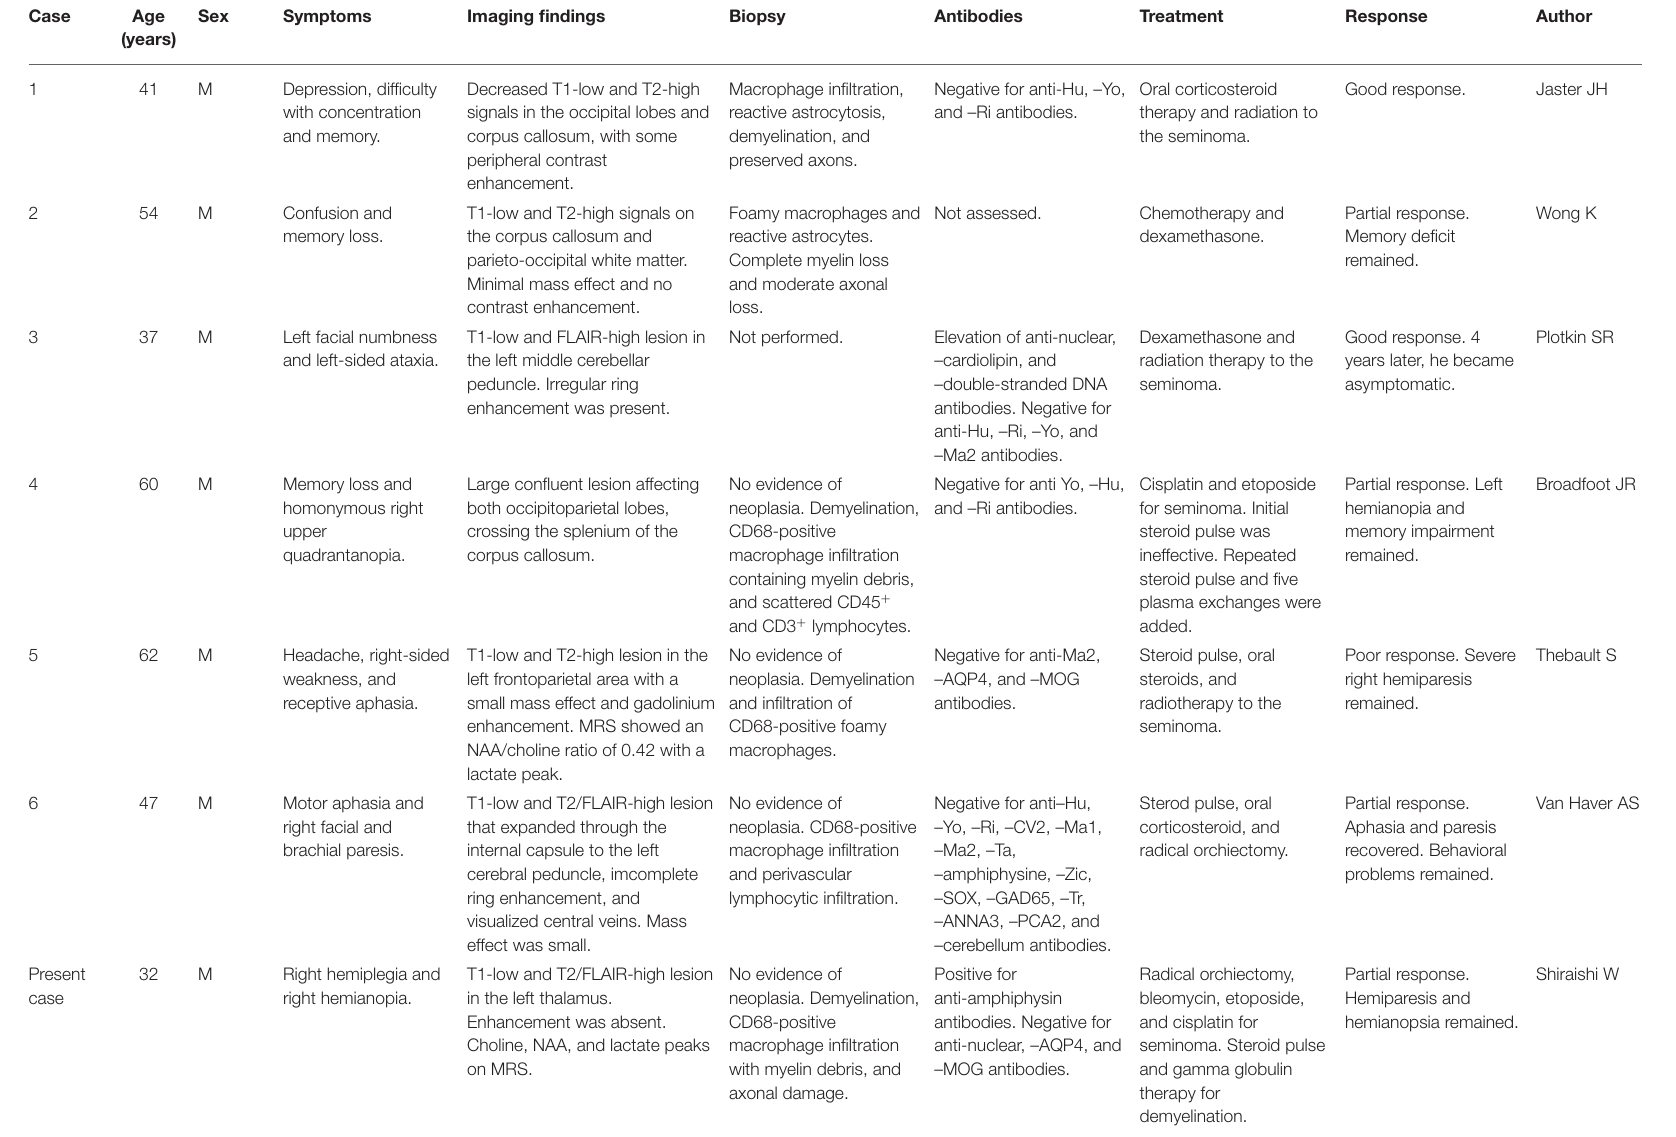
TABLE 1 | Previous cases of paraneoplastic tumefactive demyelination accompanied by